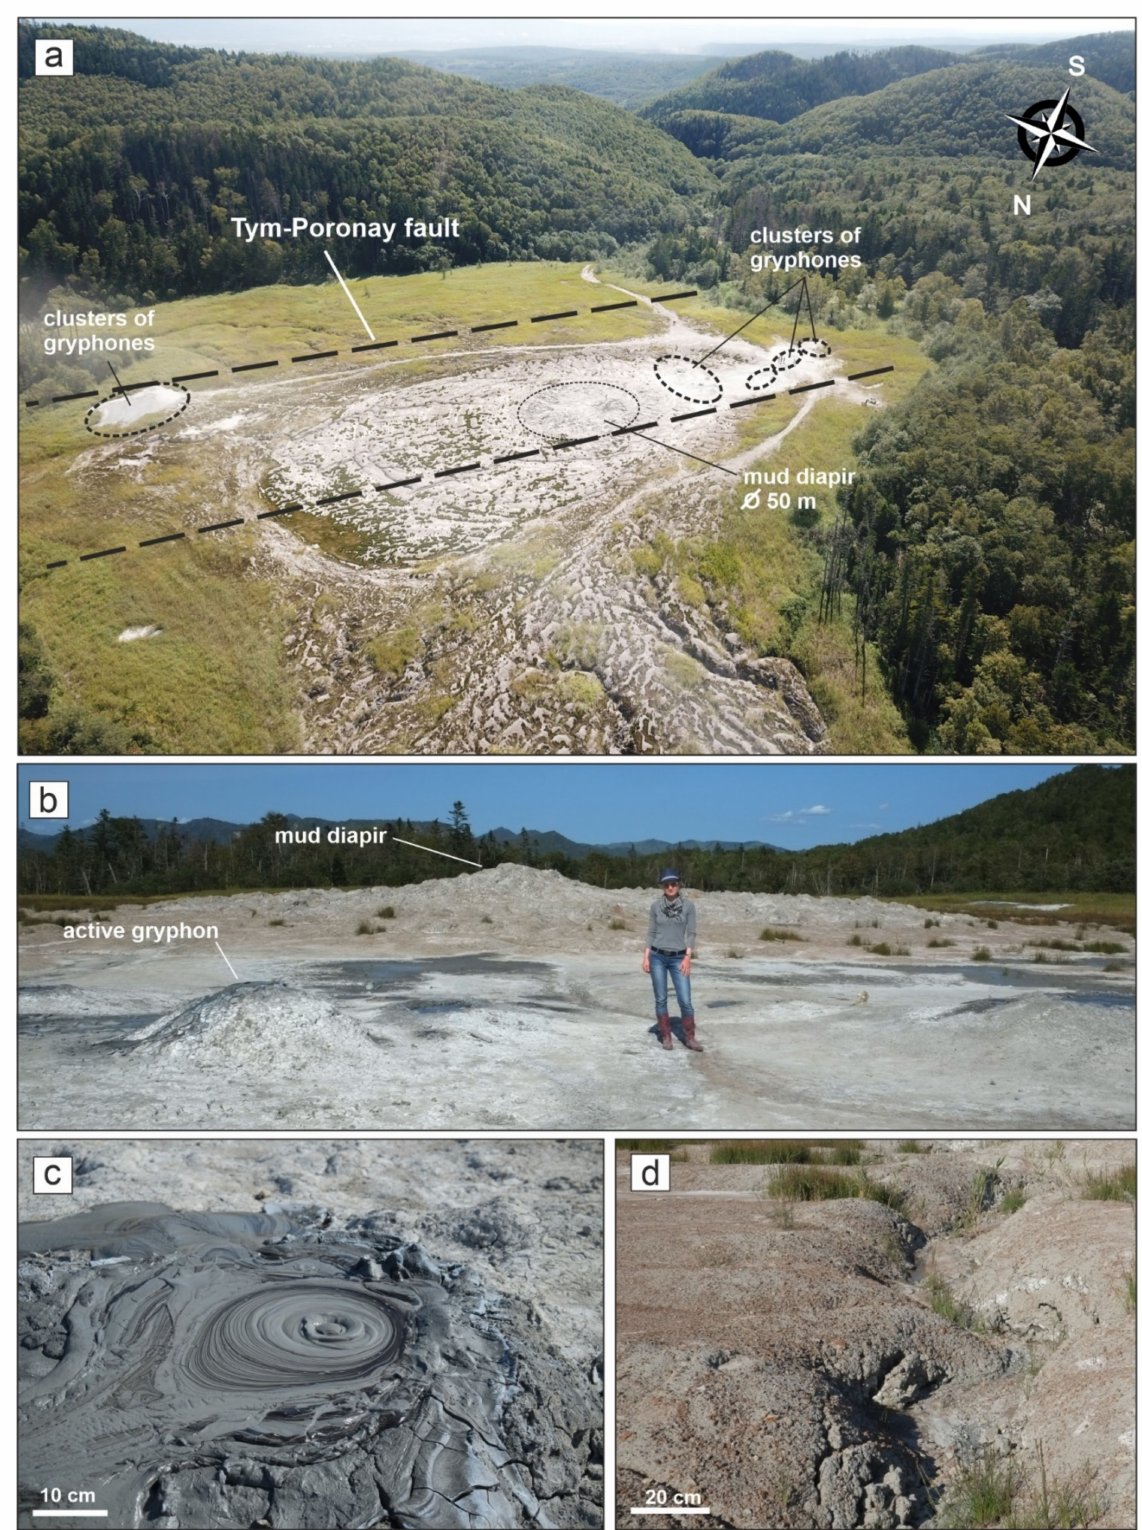
Figure 3. South Sakhalin mud volcano (47.0808 ◦ N; 142.5766 ◦ E. September 2018). ( a ) Panoramic view. ( b ) Mud diapir cut by deep cracks (at the back) and active gryphons and salsas (in the front) in the middle of the flat top of South Sakhalin MV. ( c ) Bubbling gryphon extruding liquefied mud with coal powder (black rings in grey mud). ( d ) Weathered mud cover with abundant rock fragments, Ca-Mg-rich siderite, and